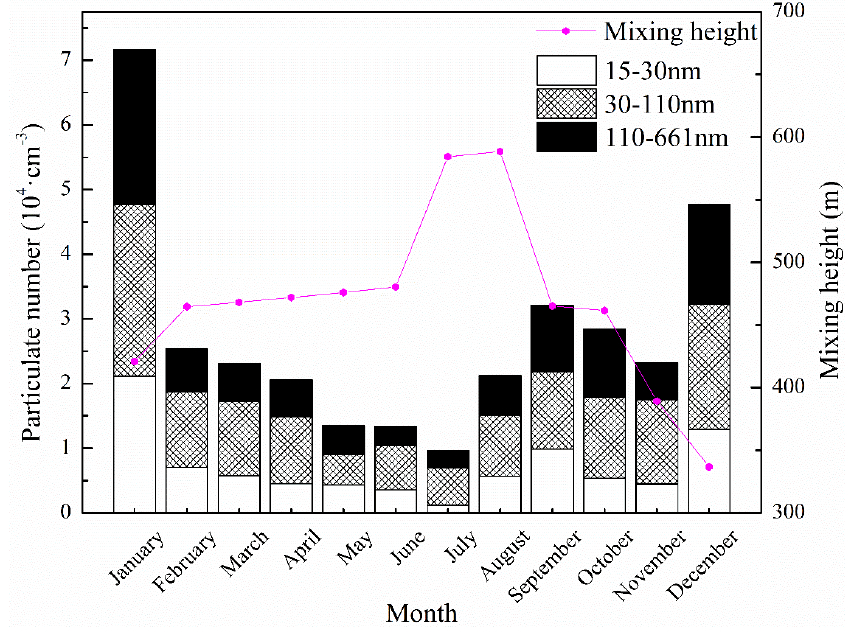
Figure 5. Monthly averaged number concentration of particles in three modes and monthly pattern of mixing layer height. mixing layer